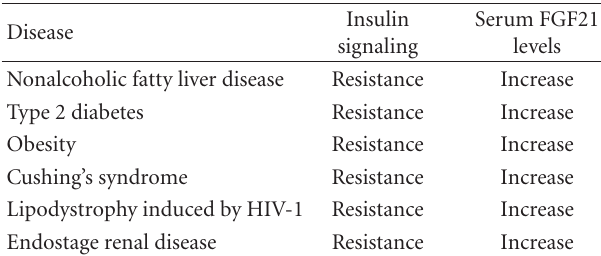
Table 1: Increased serum FGF21 levels in metabolic disease patients with insulin